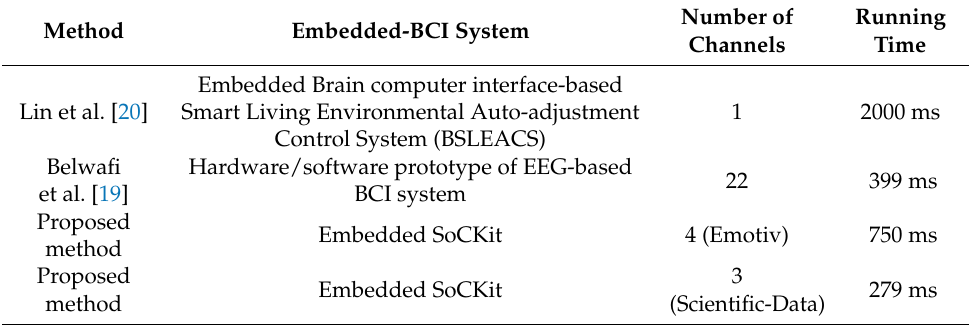
Table 8. Processing time comparison with two additional embedded-BCI